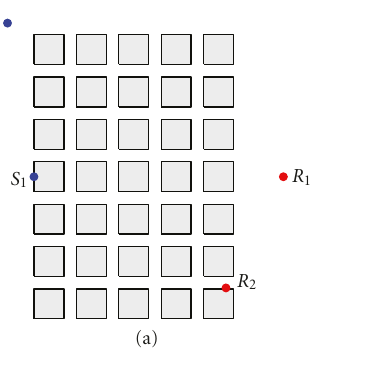
Figure 4: Plan view of the panel array used to evaluate the di ff rac- tion approximation method. The array was located 5 m above sources S 1 and S 2 and receivers R 1 and R 2 .